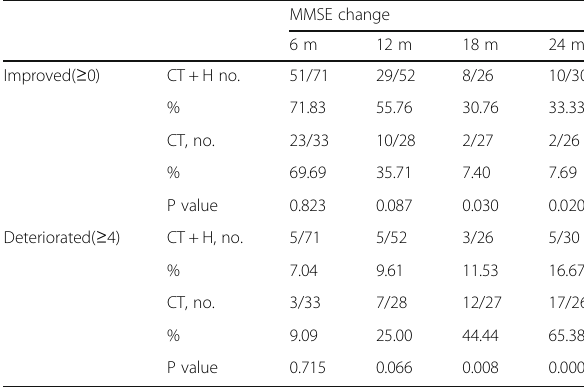
Table 4 Comparison of % of patients with improved or deteriorated MMSE